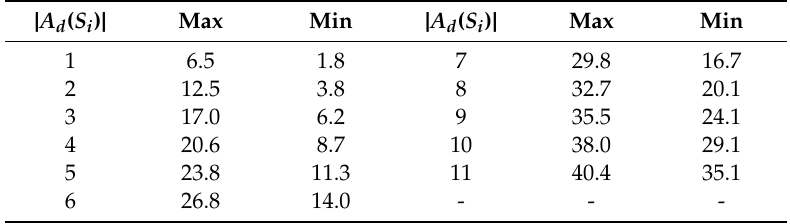
Table 12. Range of c for the distinct number of failed arcs from Table